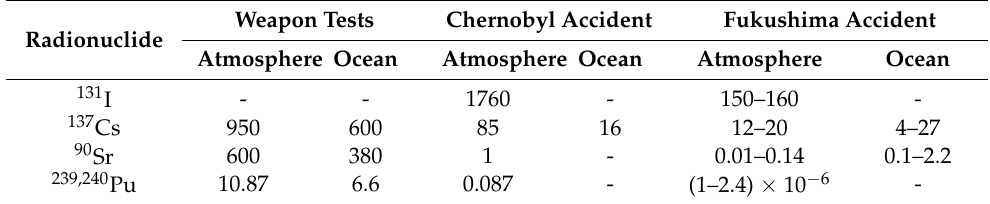
Table 1. Source and total release of artificial radionuclides (PBq). Adapted with permission from ref. [4].